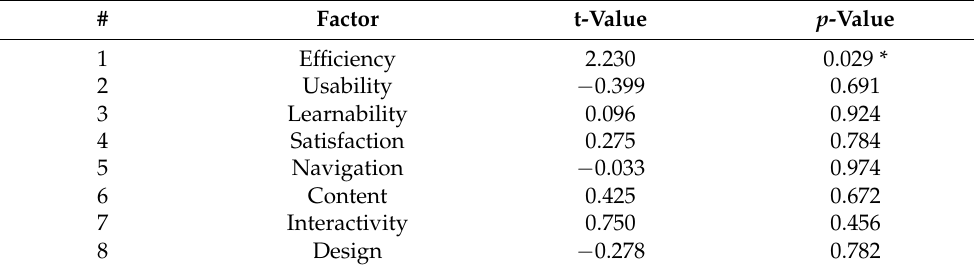
Table 7. Independent samples t -test of evaluation scores for the groups of working/ have worked as journalists or